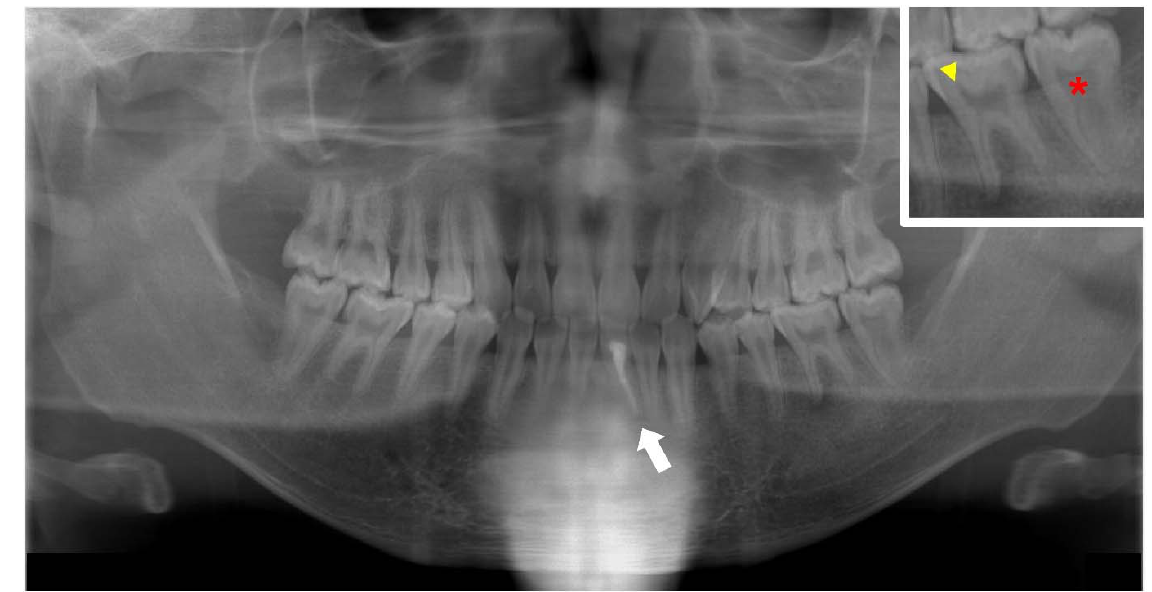
Figure 7. Panoramic radiograph of the permanent dentition of a male X-linked hypophosphatemia (XLH) patient aged 21 years who underwent root canal treatment of the mandibular left central incisor associated with a cystic swelling (arrow). The square on the upper right is an enlargement of the primary mandibular left molar region. Wide pulp chambers (asterisks) and prominent pulp horns (arrowheads) can be seen.